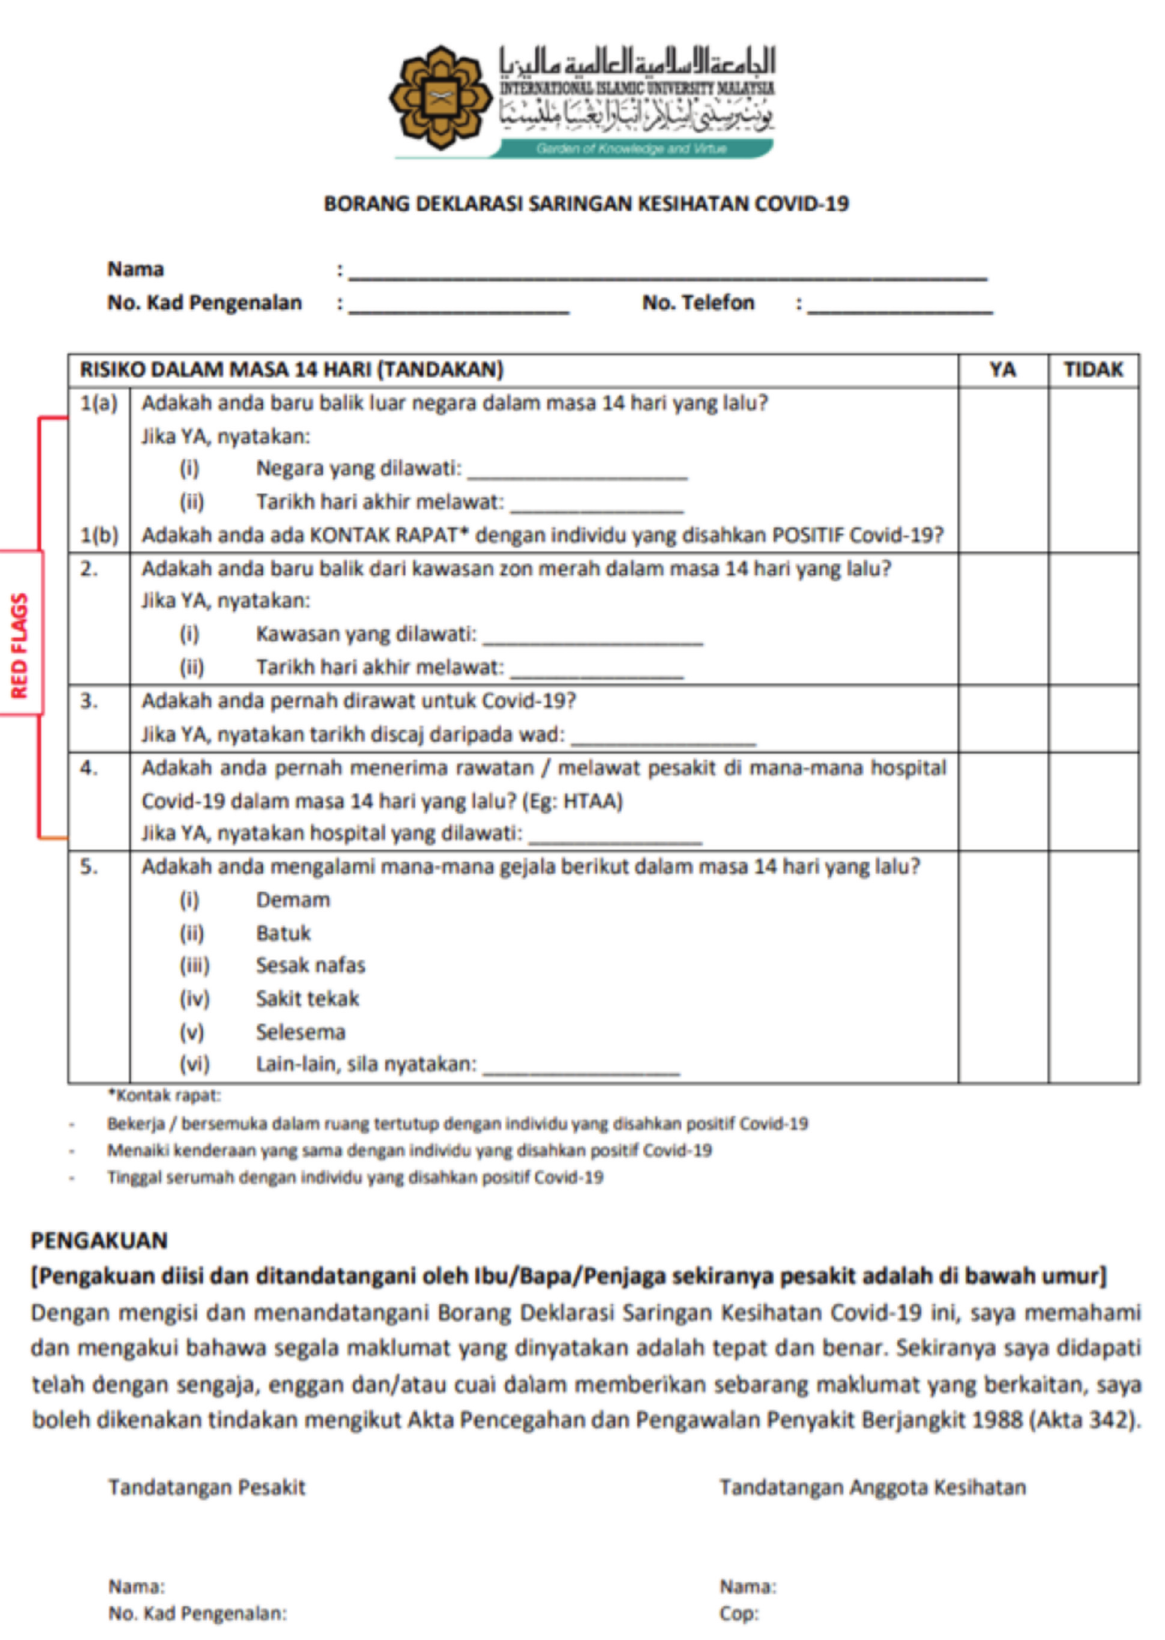
Declaration form to screen for COVID-19 during the early stage of the pandemic at Sultan Ahmad Shah Medical Centre Fig. 2: